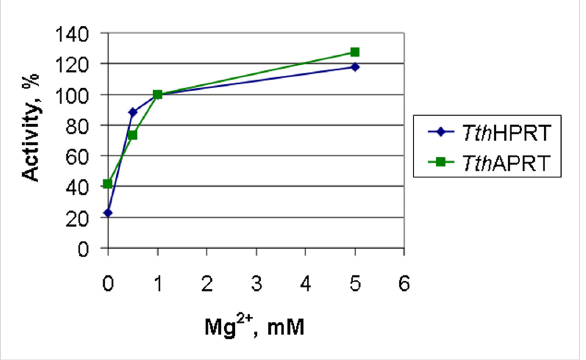
Figure 4: Dependence of Tth HPRT and Tth APRT activity on the Mg 2+ concentration (reaction mixtures (0.5 mL) contained 20 mM Tris-HCl, pH 8.0, 1 mM 5-phosphoribosyl-1- α -pyrophosphate, and 0–5 mM MgCl 2 ; in case of Tth HPRT mixtures contained 1 mM hypoxanthine and 0.18 μ g of enzyme, in case of Tth APRT – 1 mM adenine and 0.125 μ g of enzyme; reactions were performed at 70 °C; 100% –